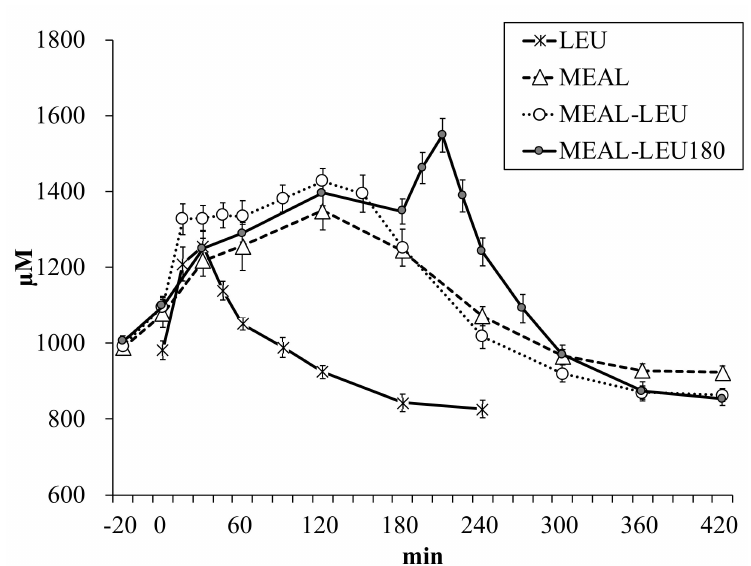
Figure 5. Mean ± SE ( n = 10) plasma EAA concentration changes over time. LEU, intake of leucine only;